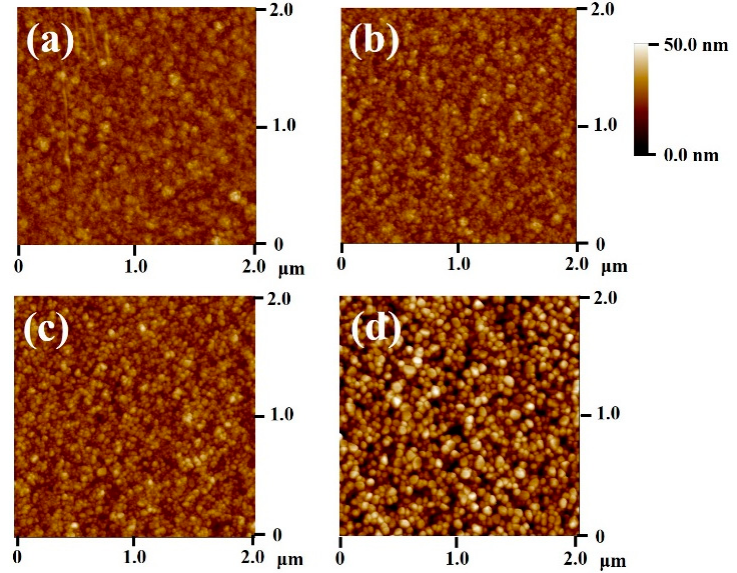
Figure 3. AFM images of WO 3 thin films with and without annealing: ( a ) as-grown, ( b ) 400 °C, ( c ) 500 °C, ( d ) 600 °C.